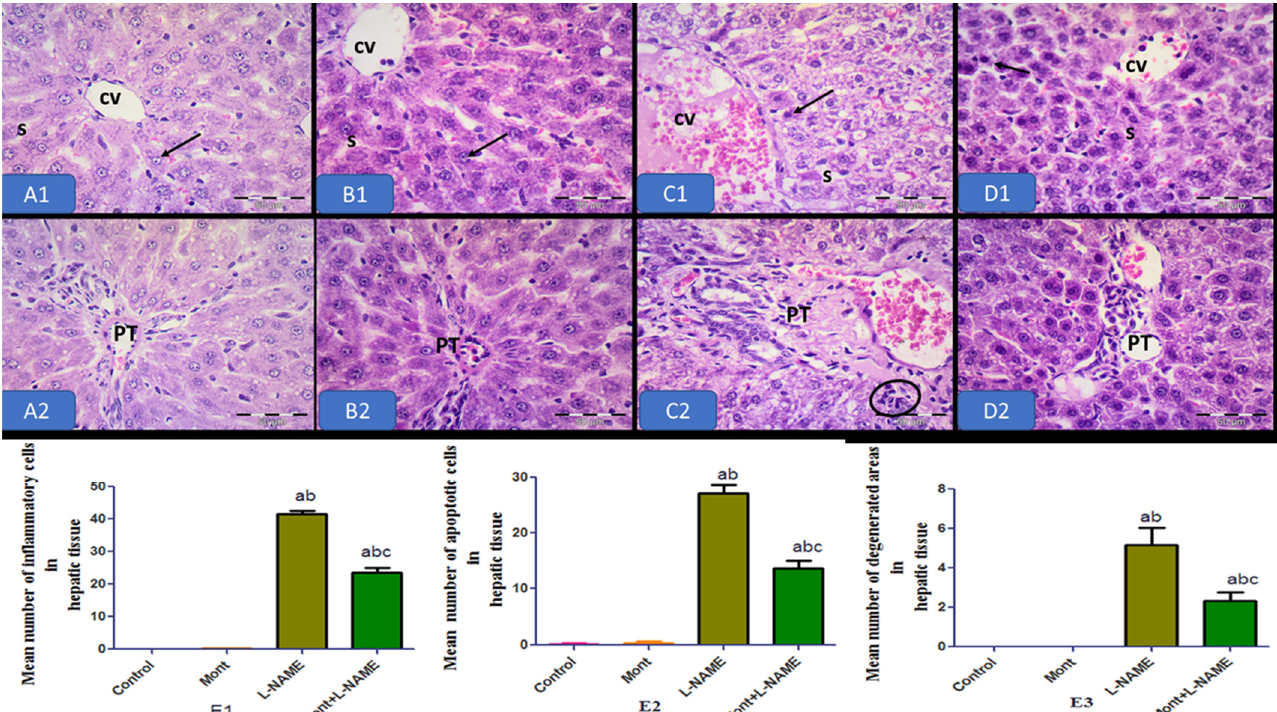
Figure 7. Effect of montelukast on the liver in a pre-eclampsia model in rats. Photomicrographs of liver tissue of the control ( A1 , A2 ) and the Mont ( B1 , B2 ) groups showing the normal organization of the liver tissue. Notice the hepatocytes (arrows) with vesicular nuclei radiating from the central veins (CV) and separated by blood sinusoids (S). Notice the portal tract (PT). ( C1 , C2 ) The L-NAME group showing dilated, congested central veins (CV) and portal tracts (PT). Notice the more numerous apoptotic cells (arrows) and inflammatory cell infiltration (circle). ( D1 , D2 ) The Mont + L-NAME group showing more or less normal liver tissue. Notice the normal central veins (CV), portal tract (PT), and hepatocytes (arrows). Notice the less numerous apoptotic cells (arrows) H&E × 400. ( E1 – E3 ) The histopathological changes in renal tissue in all groups. The data are mean ± SEM (8 rats/group). (a) Significant ( p < 0.05) difference from the control group. (b) Significant ( p < 0.05) difference from the Mont group. (c) Significant ( p < 0.05) difference from the L-NAME group. [Mont: